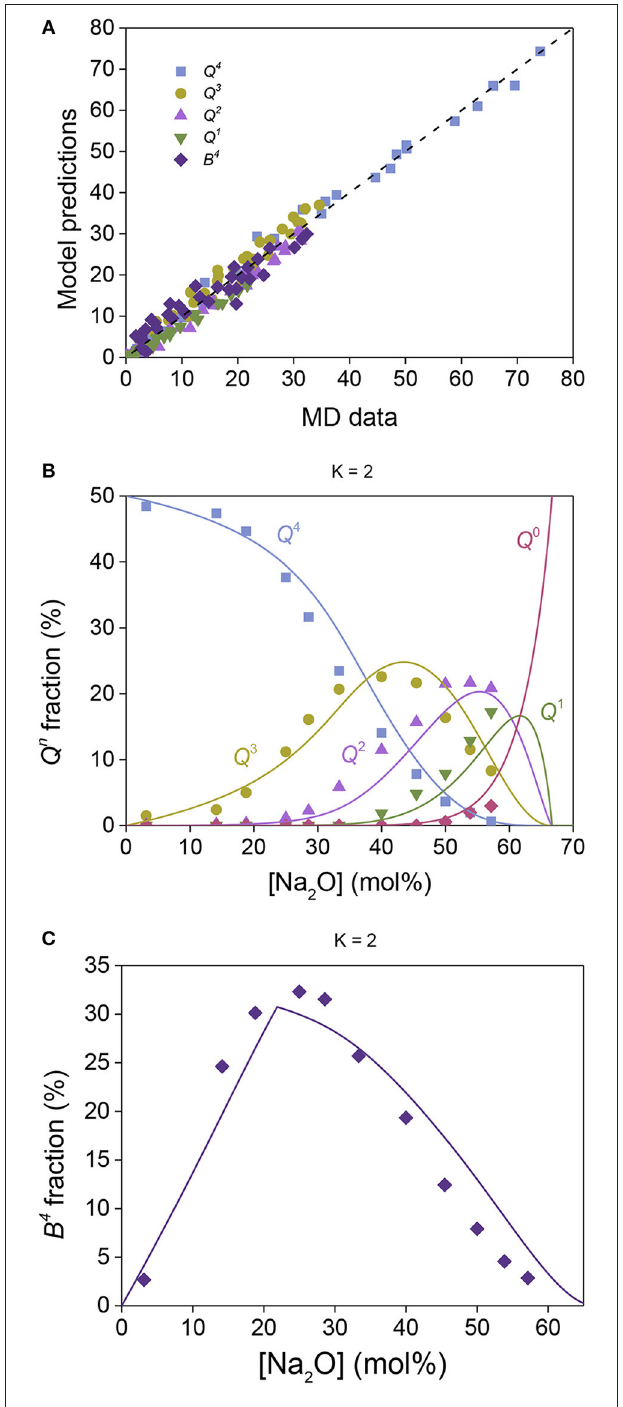
FIGURE 5 | Sodium borosilicate structural data obtained by MD simulations (Deng and Du, 2018) compared to model predictions. (A) All experimental data plotted against the model predictions, where the dashed line shows the one-to-one correlation. (B) Q n fractions for silicate structural groups (symbols) and model predictions (lines) plotted against the overall modifier concentration for glasses with K = 2. (C) Fraction of four-fold coordinated boron as obtained by MD simulations (symbols) and the model predictions (line) against the overall modifier concentration for glasses with K =